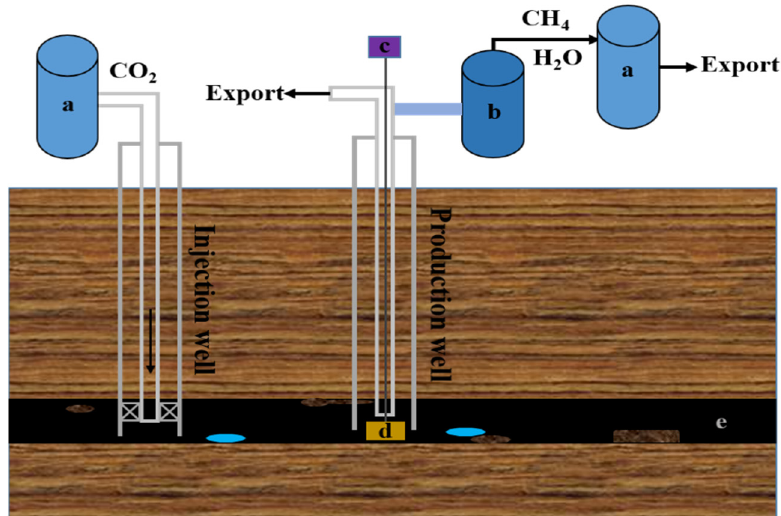
Figure 1. Schematic diagram of CO 2 storage in coal seams: ( a ) compressor; ( b ) water–gas separation system; ( c ) pump; ( d ) deep well pump; ( e ) coal seam.